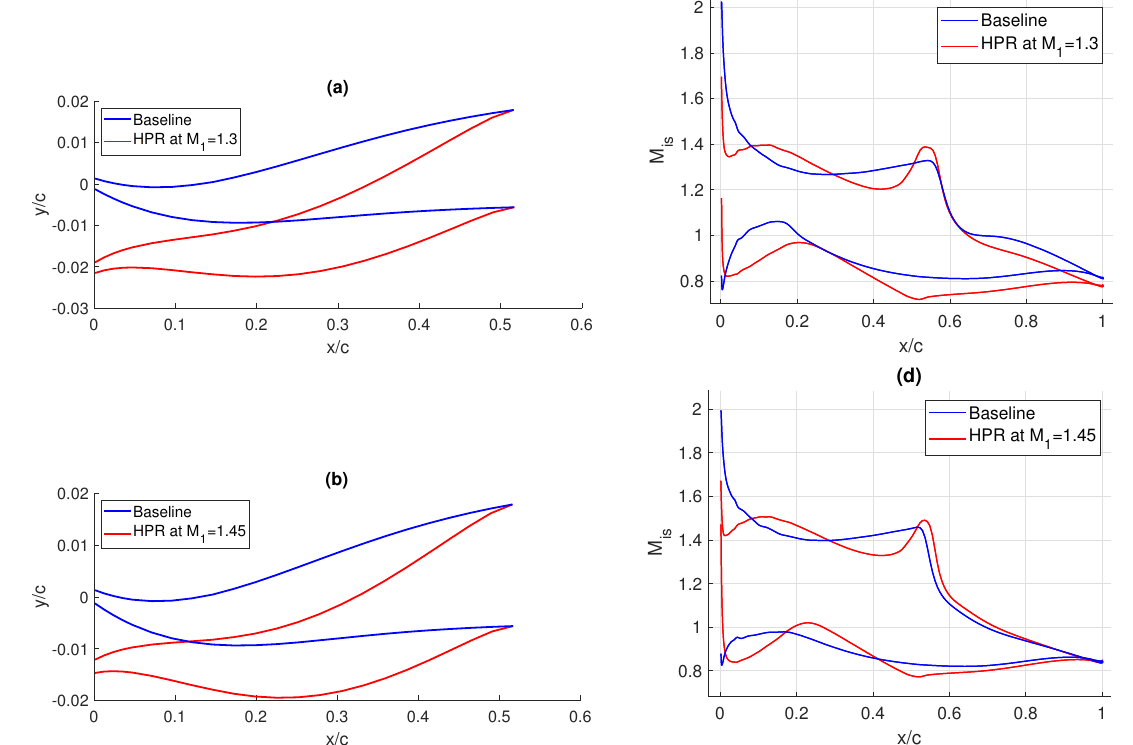
Figure 17. Front fraction shapes ( a , b ) and isentropic Mach number ( c , d ) of HPR profiles at Mach 1.3 and